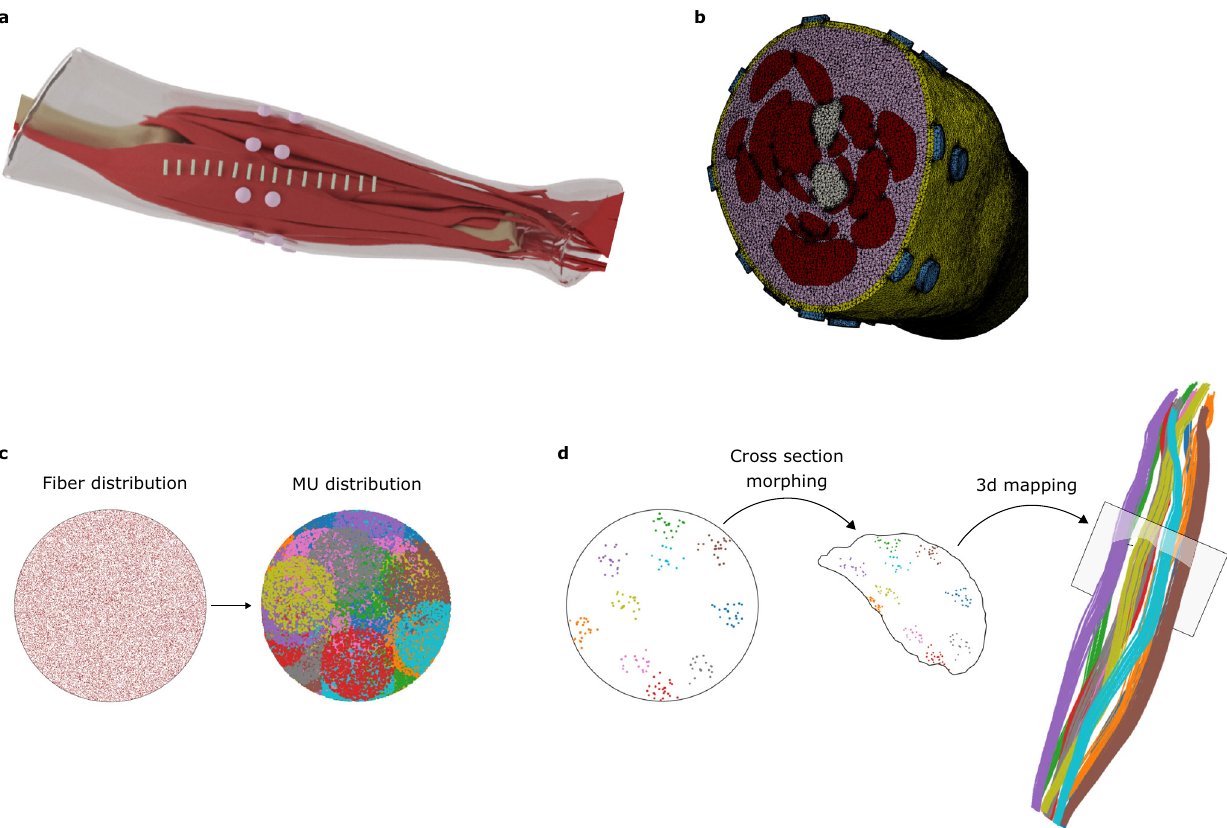
inside a unitcircleare grouped into motor units (MUs) of different sizes, locations and territories. d Example of mapping of 10 small motor units from the circle into an arbitrary muscle by morphing the unit circle into the muscle cross